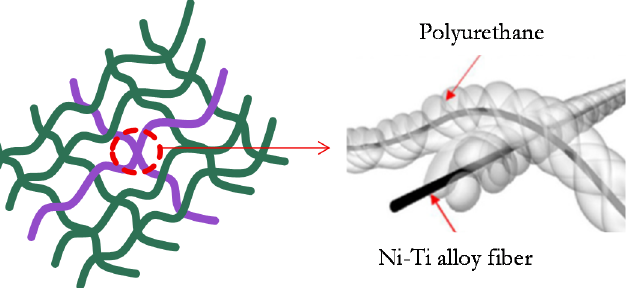
Figure 17. Textile pressure sensor based on Ni-Ti alloy fibre coated with polyurethane rubber (adapted from [140]).